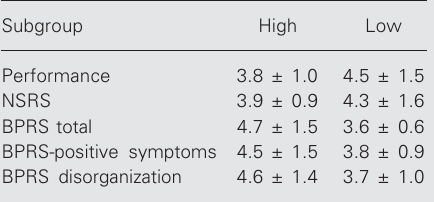
Table 1. Topographic deviation index, in µV, for subgroups of patients defined by task performance and psychopathology